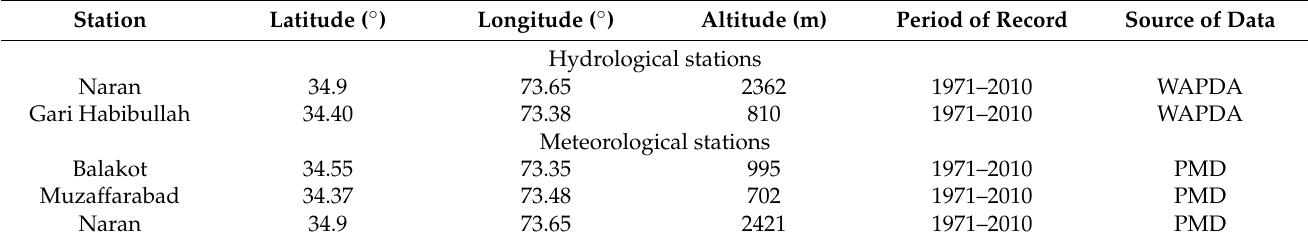
Table 2. List of hydro-meteorological data of the